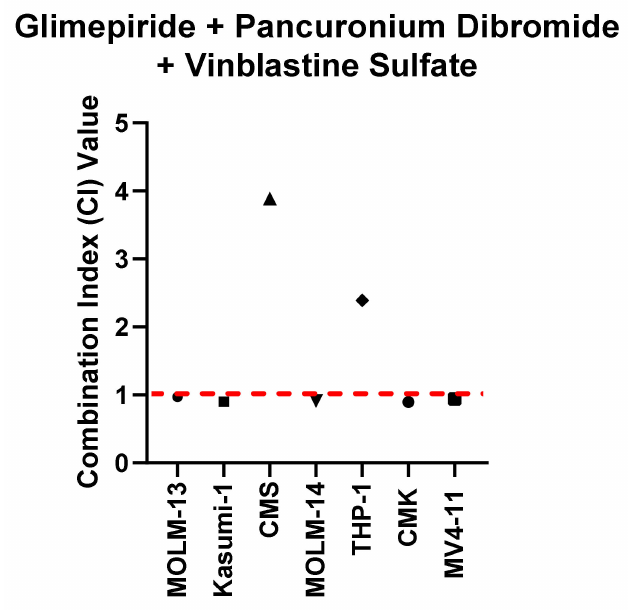
Figure 6. A panel of paediatric AML cell lines were treated with the combination of glimepiride (0.5 µ M), pancuronium dibromide (0.5 µ M) and vinblastine sulfate (0.0005 µ M) for 72 h and com- bination index values were subsequently calculated using the Chou and Talalay method. CI > 1 is antagonistic, CI = 1 is additive and CI < 1 is